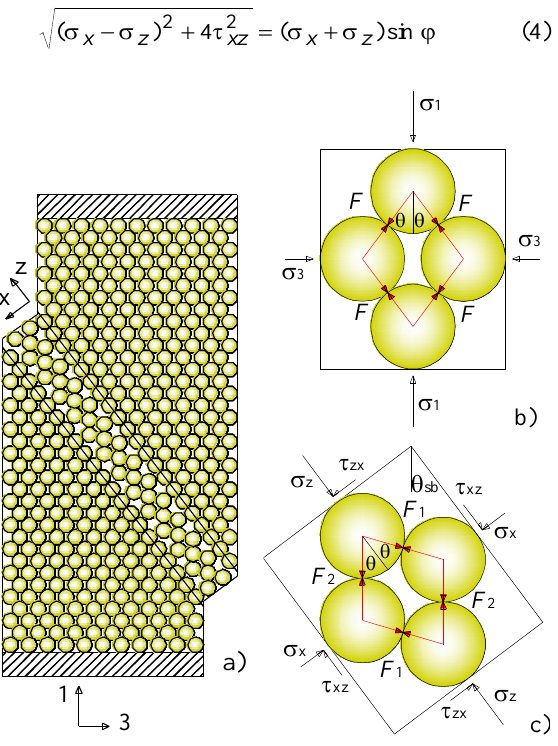
Fig. 3 Biaxial compression test: a) Assembly of ordered spheres in the elastic zones and shear band showing the higher void ratio near the lines of discontinuity, b) Packing and chains of forces in the elastic zones, and c) Packing and overall stresses at the shear band.